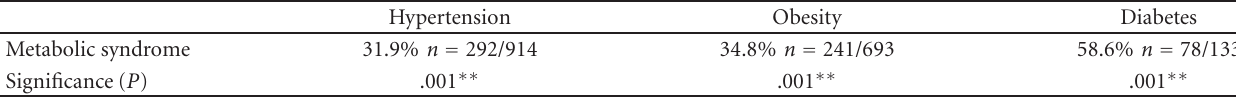
Table 6: Chi-squared independence of cardiac risk factors in the prevalence metabolic syndrome ( n =